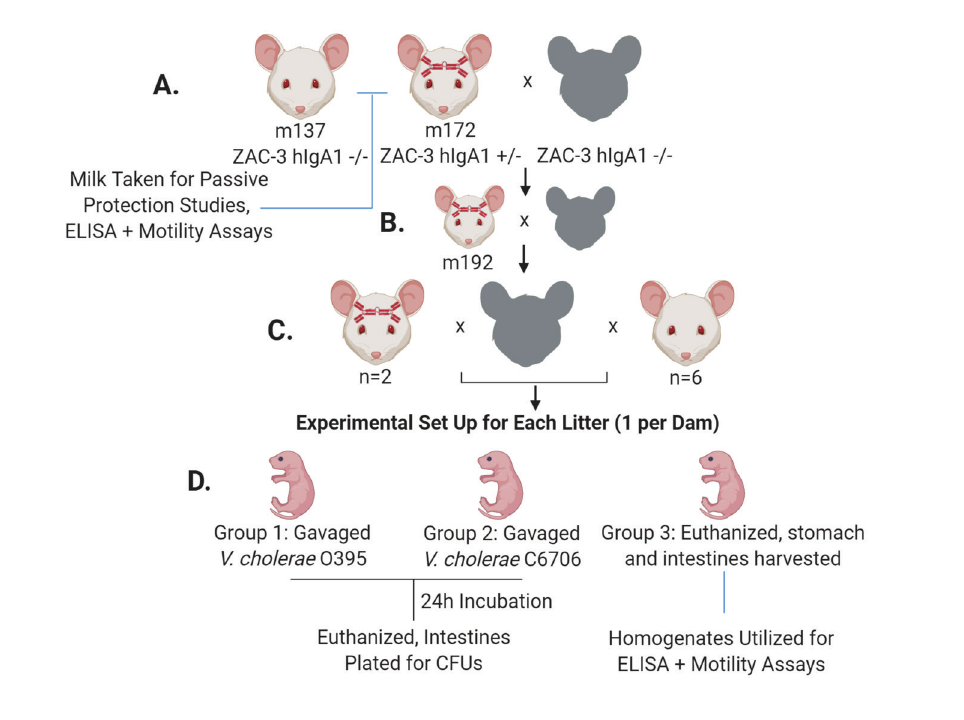
Figure 1. ZAC-3 hIgA Transgenic Mice Mating Scheme and Experimental Design . (A) Transgenic mouse m172, and a control mouse, m137, were bred with WT CD-1 males. Milk samples were taken for passive protection, ELISA and motility assays. (B) Resulting F1 progeny, m192, was bred with a WT CD-1 male. (C) From this pairing 8 F2 progeny females, 2 ZAC-3 hIgA positive, and 6 hIgA negative, were bred with WT CD-1 males. (D) F3 litters were taken at 4 to 5 days old for colonization experiments. Each litter, 1 per mating pair, was divided into 3 groups. At the time of gavage, Group 3 (1-2 pups depending on litter size) was euthanized, and stomach and intestines were excised and homogenized in PBS containing pro- tease inhibitor. These homogenates were later used for ELISA and motility assays. Remaining litter mates were divided into Group 1 and 2, containing approximately equal numbers, and gavaged with ~1 × 10 7 V. cholerae O395 or C6706 strains respectively. After 24-hour incubation, pups were euthanized and whole intestines were plated onto selective media for CFUs, which serve as a surrogate for intestinal colonization of V. cholerae . This figure was created with